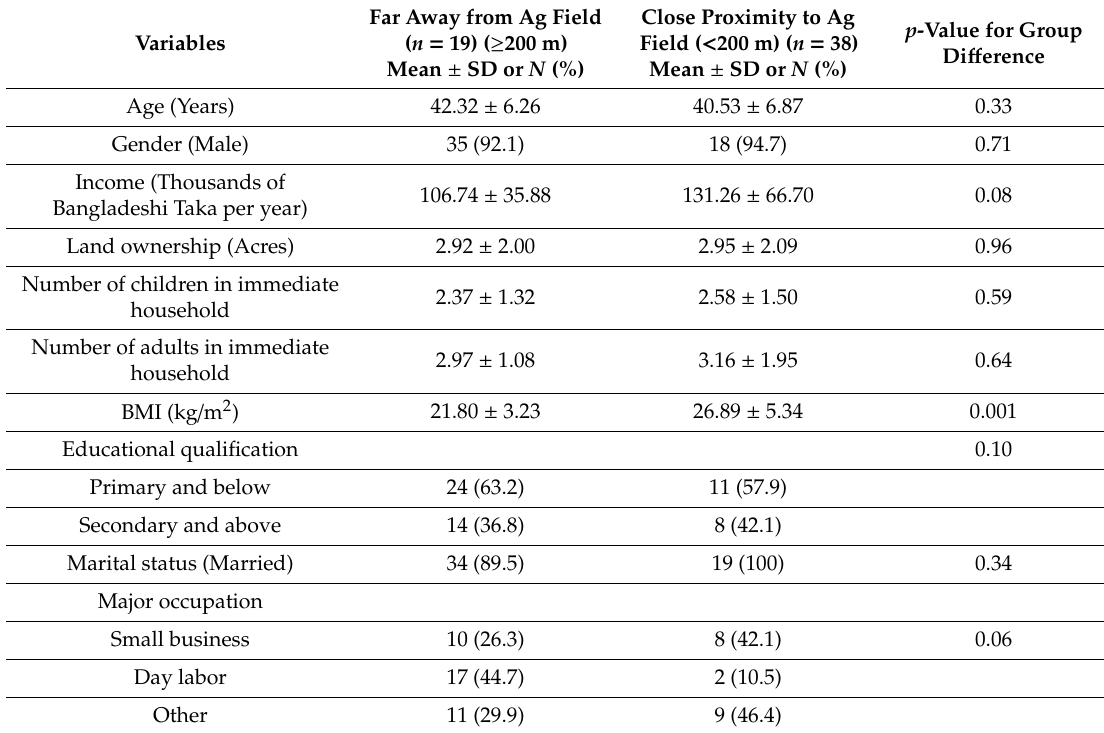
Table 1. Sample sociodemographic characteristics ( n = 57).